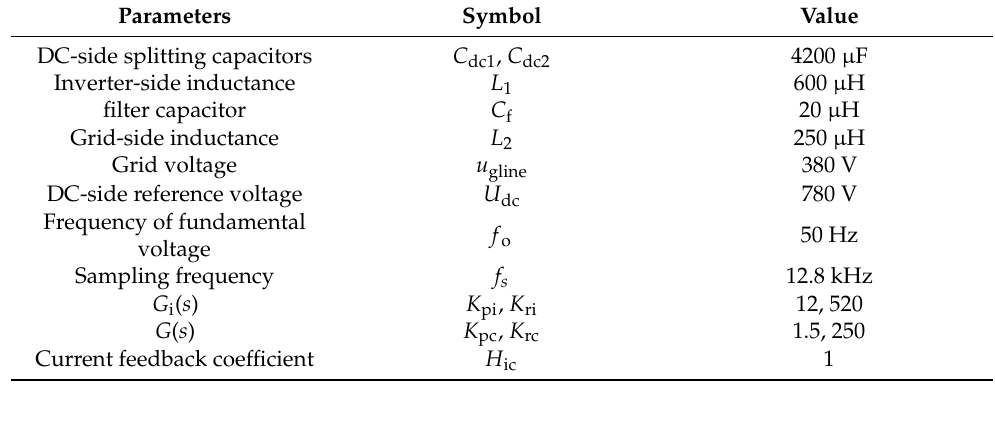
Figure 7. Closed-loop pole diagrams of the system under various grid impedances.